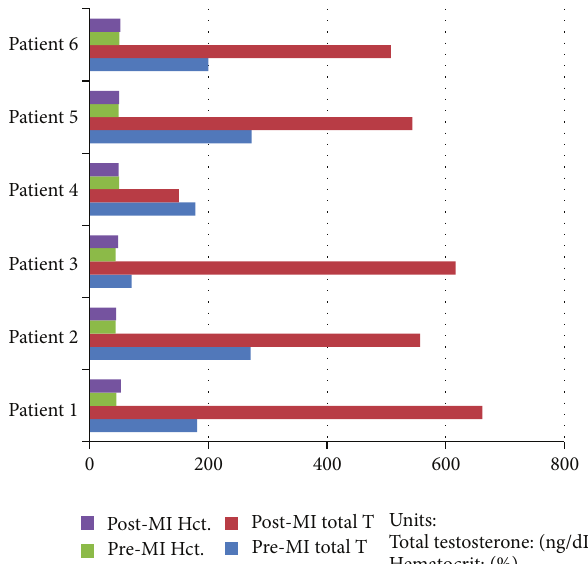
Figure 4: Changes of testosterone levels and hematocrit in patients with MI during